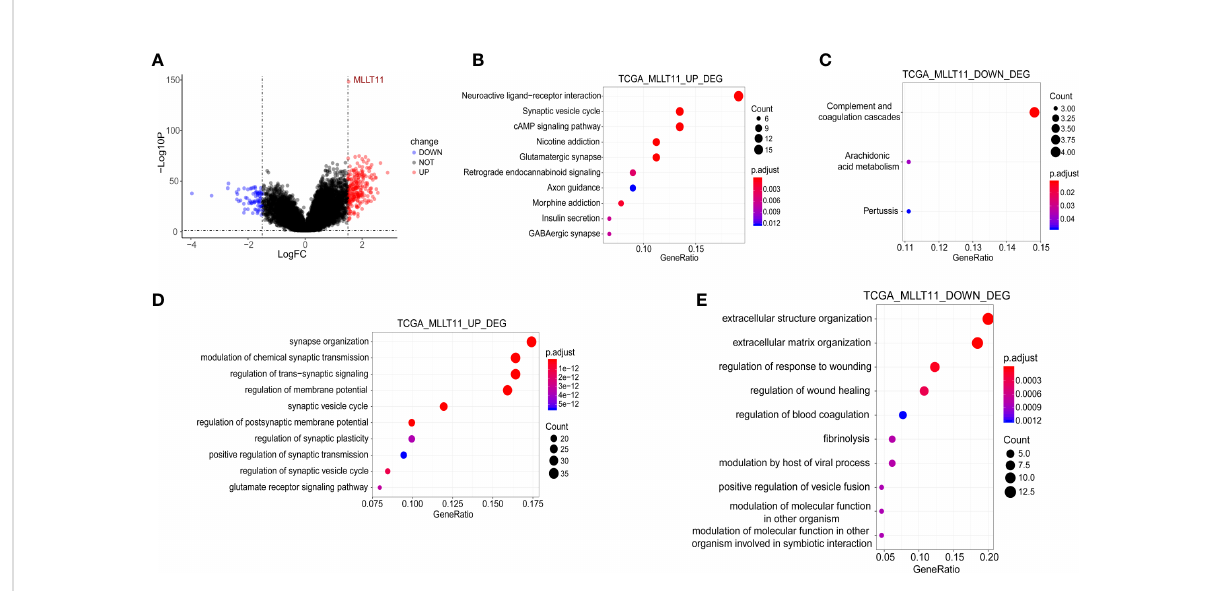
FIGURE 4 Functional enrichment analysis between the MLLT11 high- and low ‐ expression groups in gliomas. (A) Differential expression genes (DEGs). (B, C) KEGG enrichment analysis of the upregulated genes in the high MLLT11 subgroup and the downregulated genes in the high MLLT11 subgroup. (D, E) GO analysis of the upregulated genes in the high MLLT11 subgroup and the downregulated genes in the high MLLT11